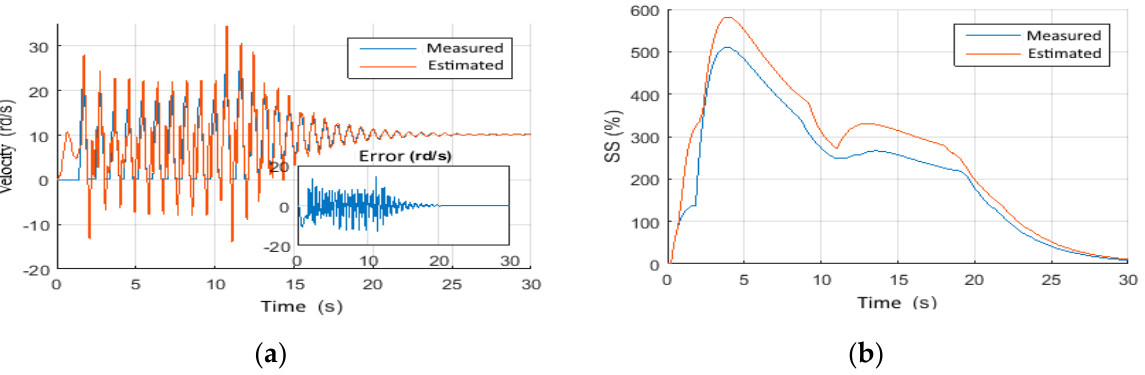
Figure 13. Measured and estimated variables by the designed observer: ( a ) Rotational velocities, ( b ) Stick-slip severity.